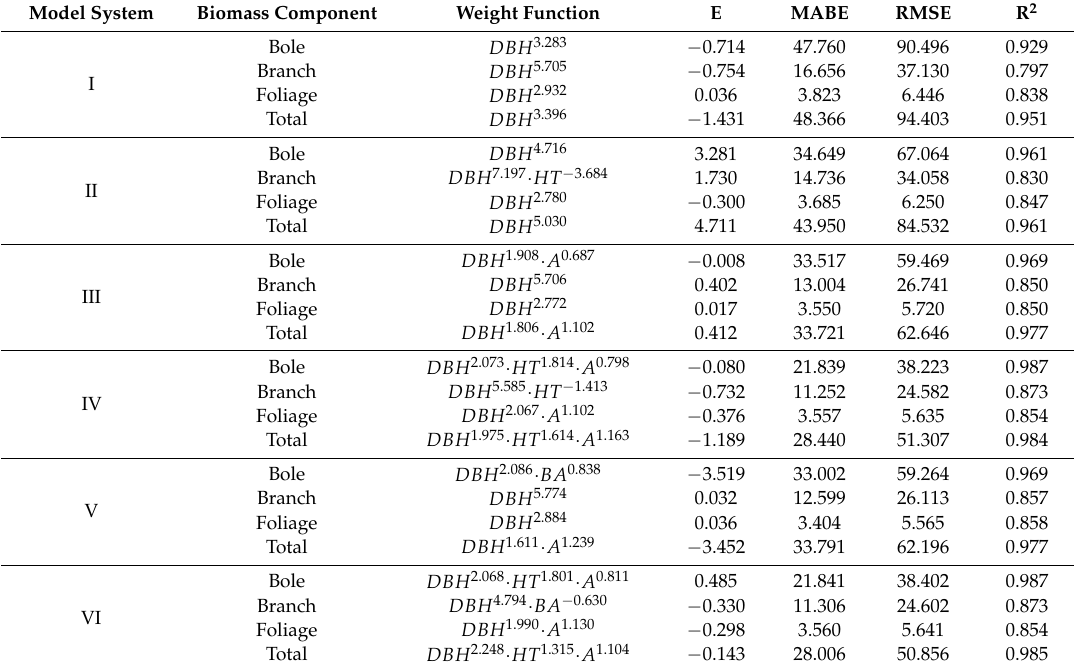
Table 9. Weight functions and fit statistics for each component in the additive biomass equation systems. Model